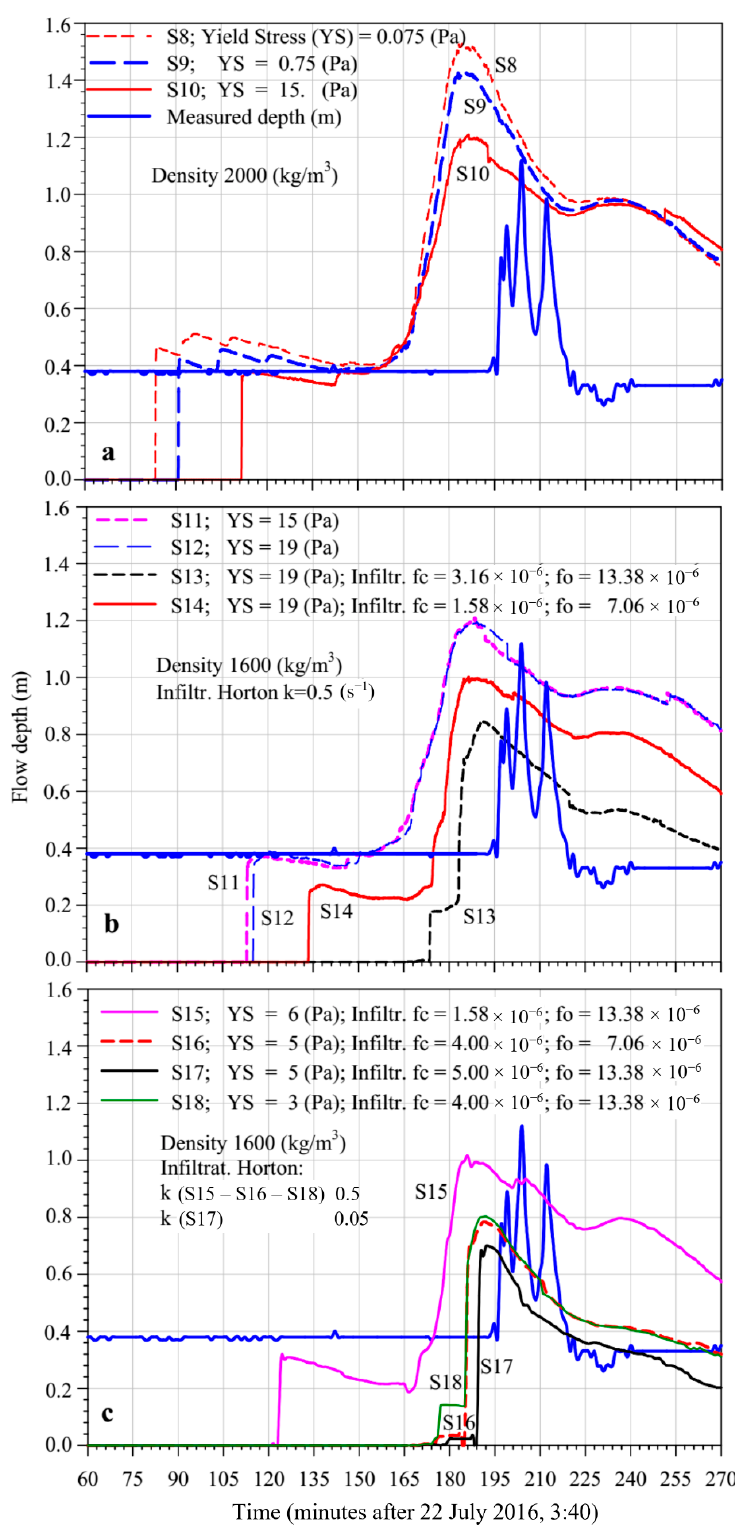
Figure 5. Inclusion of the available 5 rainfall time histories; Manning’s n factor = 0.055; Angle = 3°; ( a ) no infiltration, Yield stress variations, density equal to 2000 kg/m 3 ; ( b ) Horton’s infiltration model, Yield stress variation, infiltration parameters variation, k = 0.5 s − 1 , density equal to 1600 kg/m 3 ; ( c ) Horton’s infiltration model, Yield stress variation, infiltration parameters variation, k = 0.5 s − 1 and k = 0.05 s − 1 for simulation S17, density equal to 1600 kg/m 3 .